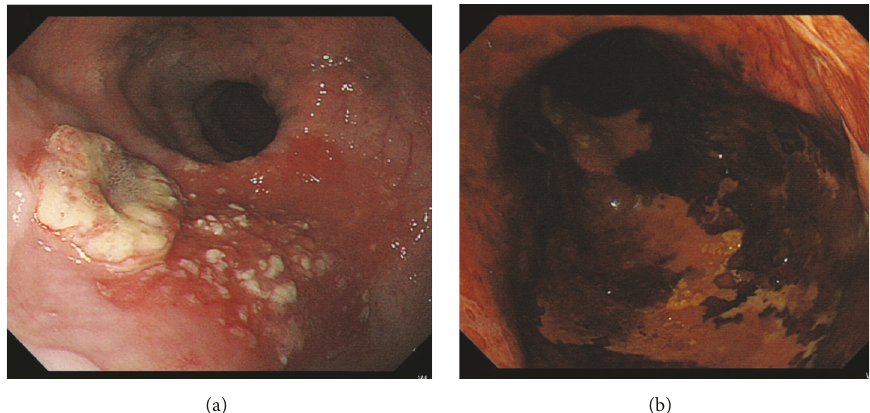
Figure 1: Upper gastrointestinal endoscopy showed a “0-IIb+IIa” lesion in the middle esophagus (a). Iodine staining revealed multiple irregularly shaped iodine-unstained areas (b).